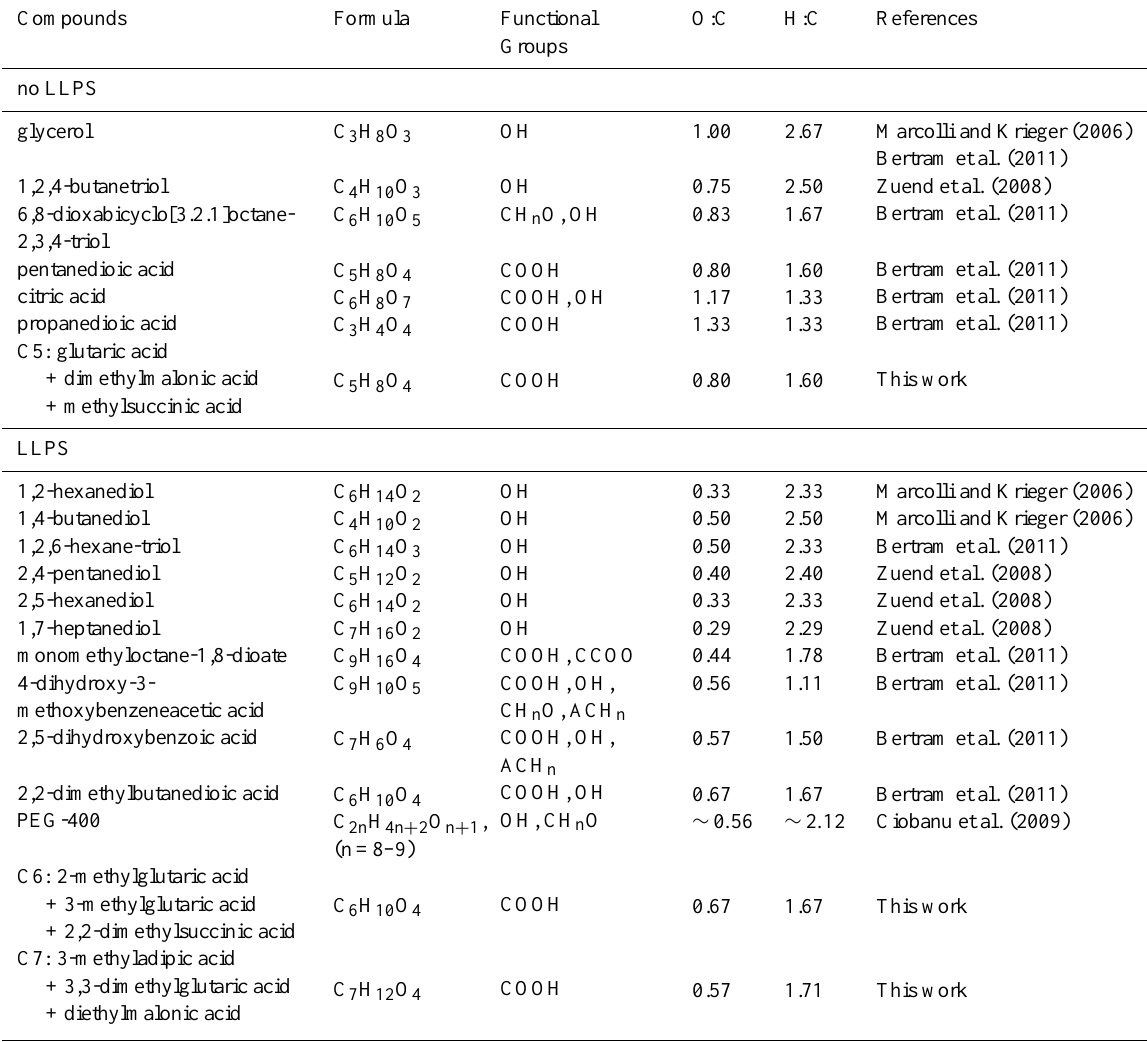
Table 2. List of “no LLPS” and “LLPS” exhibiting mixtures consisting of aqueous AS with organic components containing hydroxyl (OH), carboxyl (COOH), ether (CH n O), ester (CCOO), and aromatic (ACH n ) functional groups. Range of experimental conditions: 30% < RH < 100% and mf d (AS) > 0.1. Data from the literature and this work. Compounds Formula Functional O:C Groups